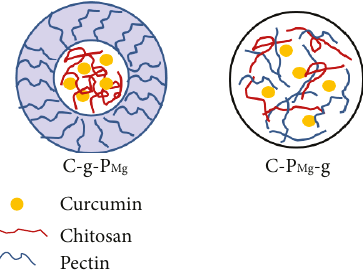
Figure 2: Schematic presentation of C-g-P formulated by methods A and